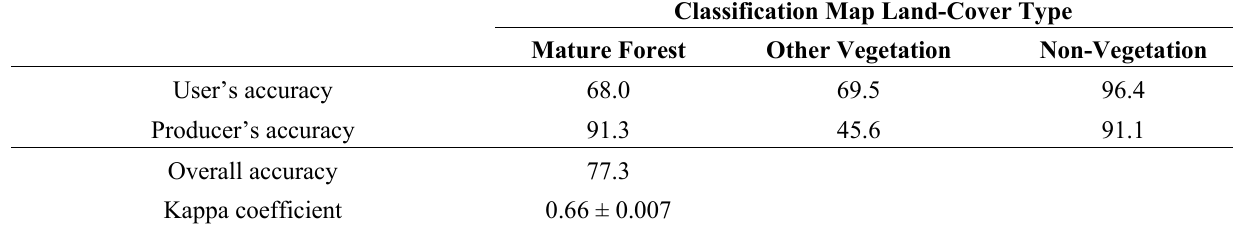
Table A3. Cont . Classification Map Land-Cover Type